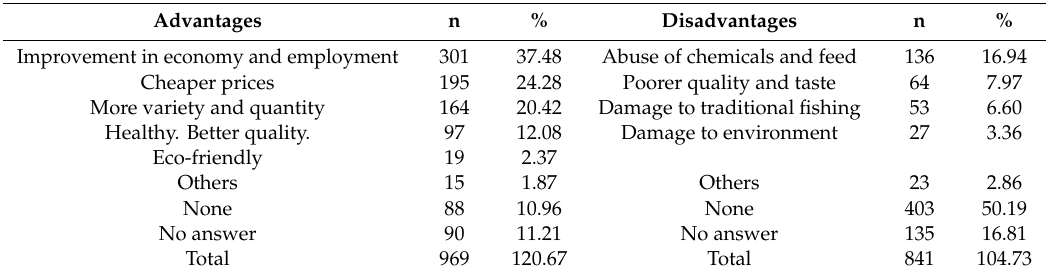
Table 4. Advantages and disadvantages of